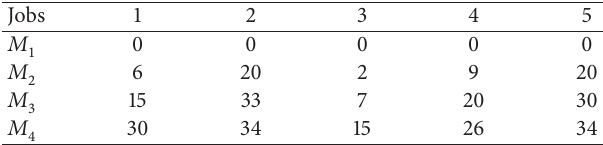
Table 7: Initial values of release dates of Example 3.